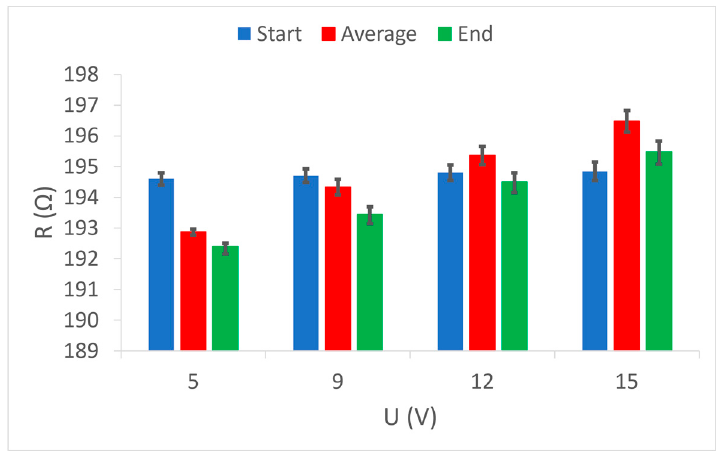
Figure 9. Comparison of three resistance values (start, average, end) at given voltage values in sample 1.